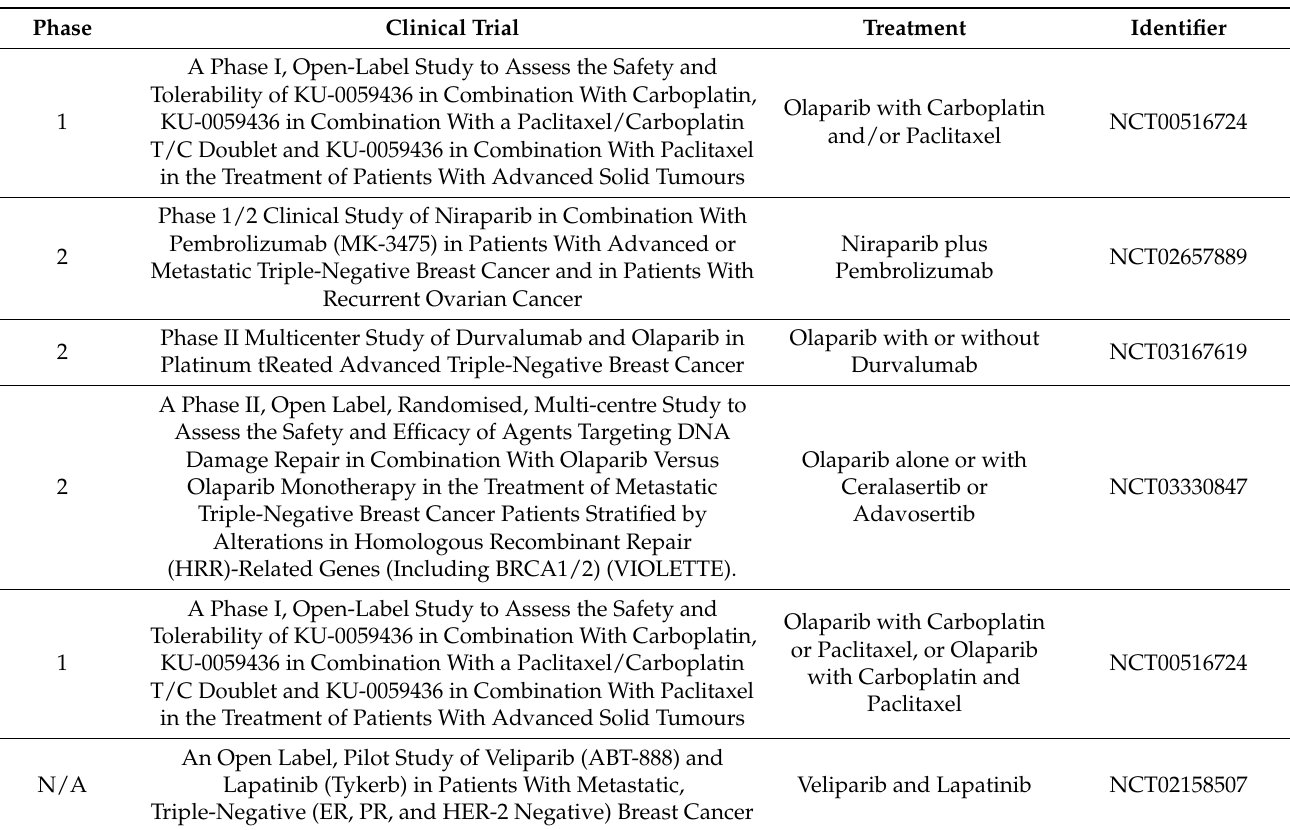
Table 2. List of all the active non-recruiting clinical trials of PARP inhibitors in TNBCs.